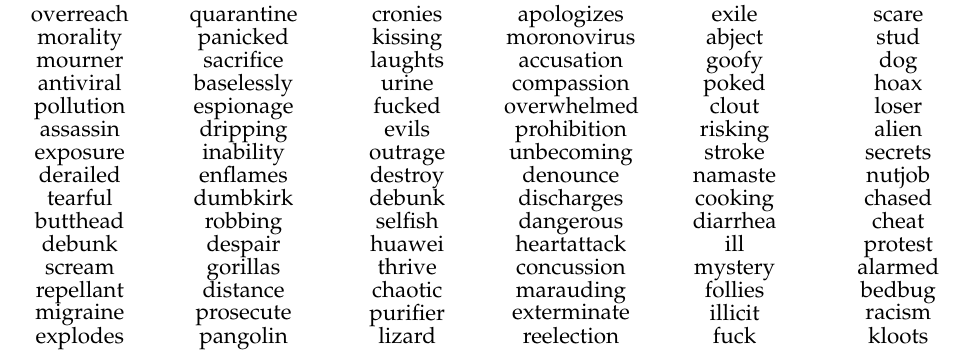
Table 4. Cluster of “Chinavirus”, 16–31 March